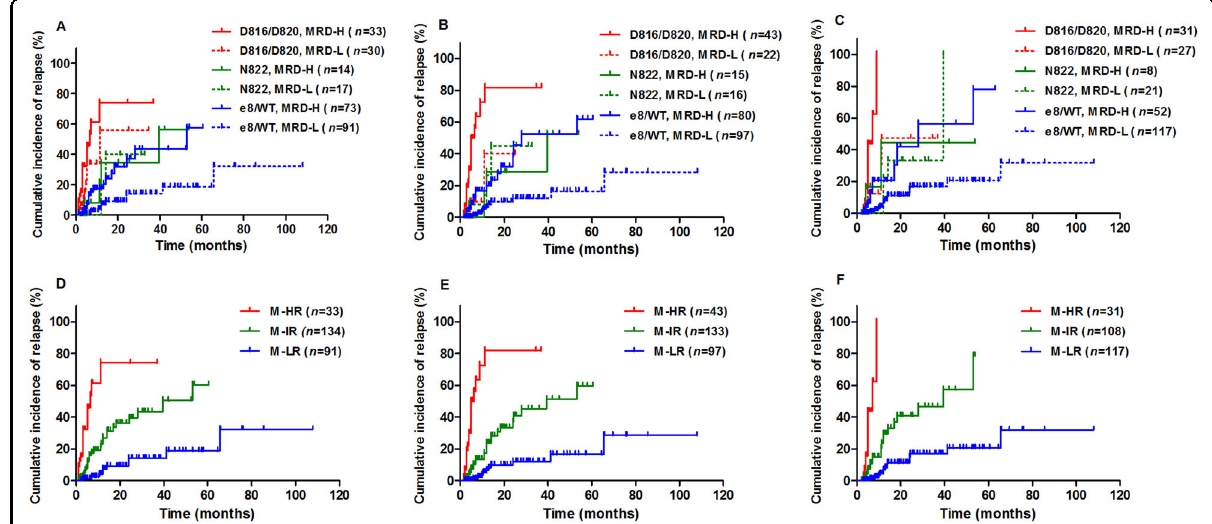
Fig. 1 CIR with allo-HSCT patients censored at the time of transplantation and patients were categorized by the combination of KIT mutations and MRD status at different timepoints. A , D At CR; B , E : after 1st consolidation; C , F : after 2nd consolidation. MRD-H and MRD-L represented <2-log reduction and ≥ 2-log reduction of RUNX1-RUNX1T1 at CR ( A ) and <3-log reduction and ≥ 3-log reduction of RUNX1-RUNX1T1 after 1st and 2nd consolidation ( B , C ),